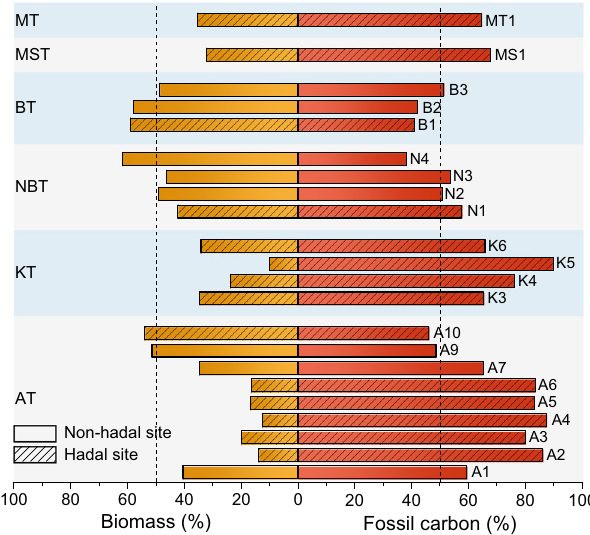
Fig. 6 Radioactive carbon isotopic composition ( Δ 14 C)-based estimate for proportion (%) of fossil carbon and biomass burning to the Black carbon (BC) pool in surface sediments from six trench regions. AT Atacama Trench, BT Bougainville Trench, KT Kermadec Trench, MST Mussau Trench, MT Mariana Trench, NBT New Britain Trench. The vertical dash lines denote 50%